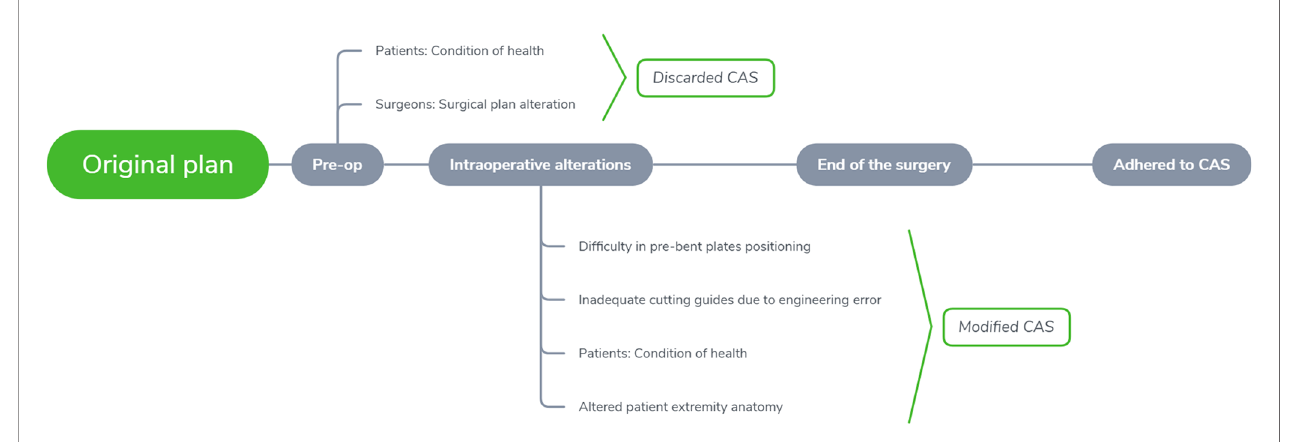
FIGURE 3 | Flowchart of surgical adherence to computer-assisted surgery.